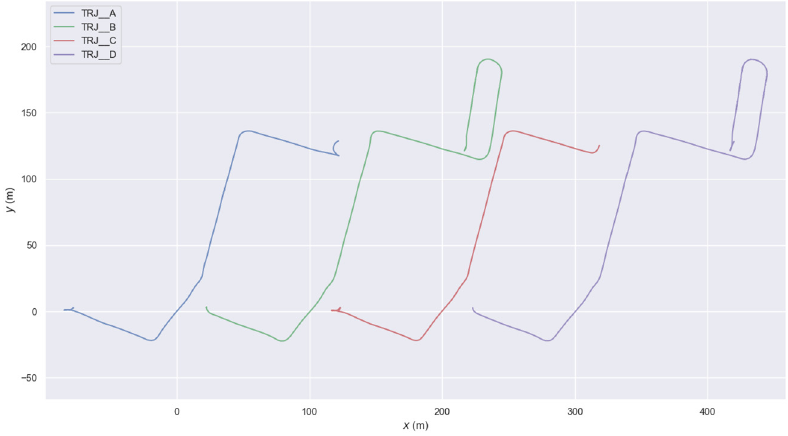
Figure 13. Positioning trajectories between ore loading and unloading points based on EQT map with resolution of 8 cm.